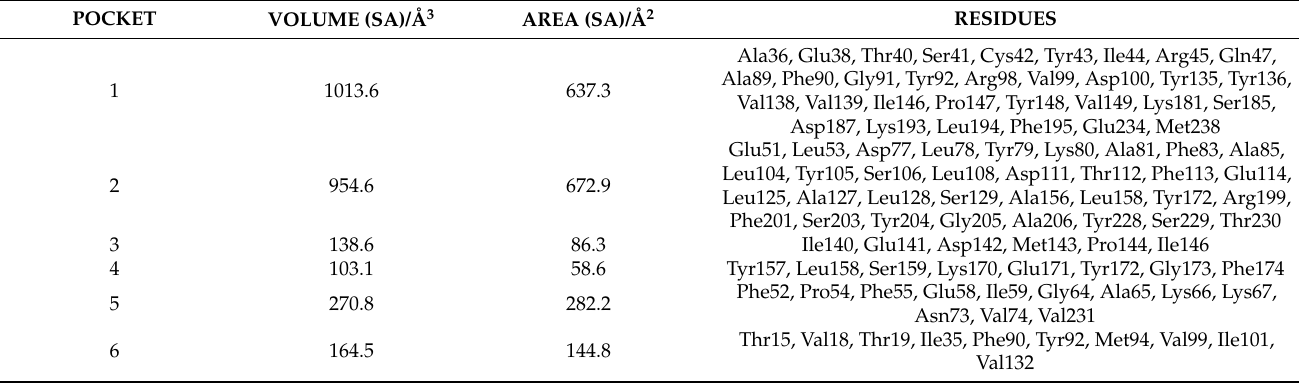
Table 2. Top 6 binding pockets of ROB2 predicted by CASTp and the amino acid residues lining the pockets. Solvent accessible (SA) values are shown. The volumes and areas of the binding site cavities are measured in Å 3 and Å 2 ,